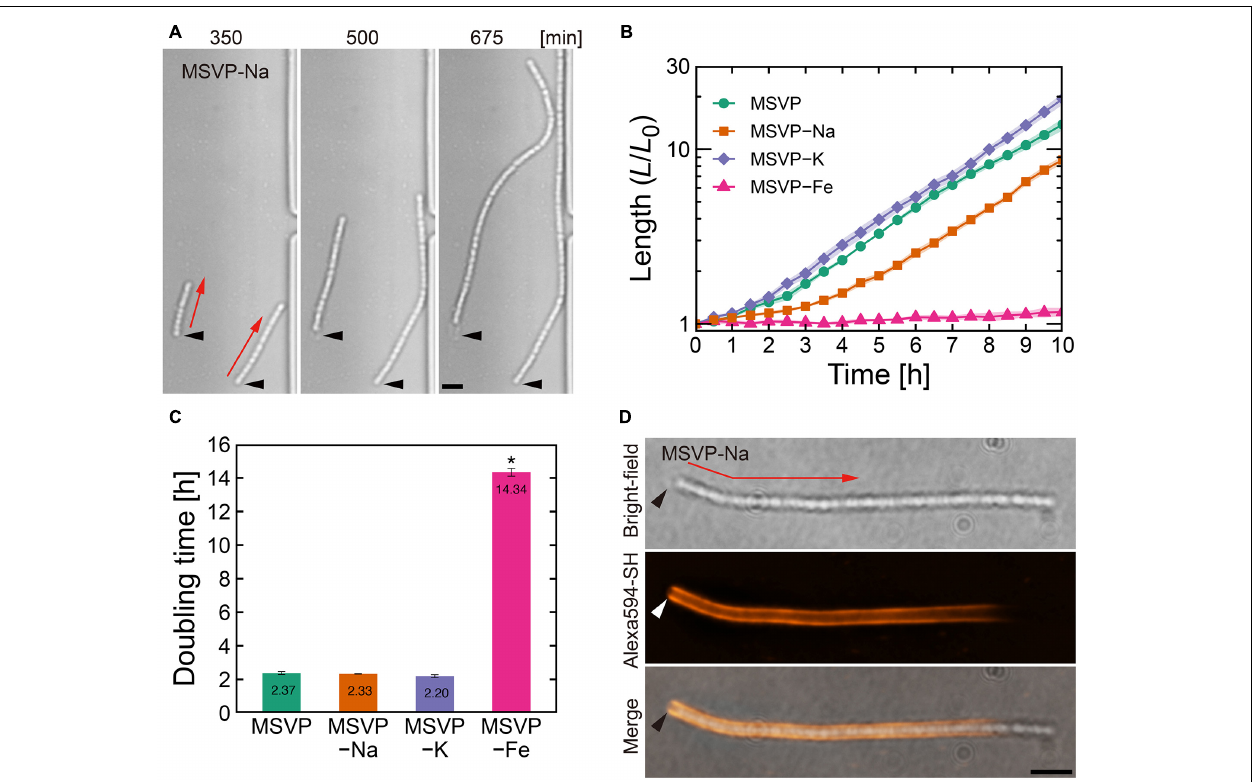
FIGURE 1 | Filament elongation in the normal mode. (A) Time-lapse image sequence showing filamentous growth in MSVP-Na. The start time ( t = 0) is defined as when the first cell makes initial surface attachment. (B) Average length of three independent cell filaments measured as a function of time in MSVP, MSVP-Na, MSVP-K, and MSVP-Fe. The filament length ( L ) is normalized by the initial length ( L 0 ) at t = 0. Filled regions represent the standard deviation (SD) from three experiments. (C) Doubling time of filament length during exponential growth in MSVP, MSVP-Na, MSVP-K, and MSVP-Fe, respectively, measured from three cells. The error bars represent the SD. The significant difference compared to growth in MSVP is calculated using Dunnet’s test ( n = 3, * P < 0.0000001). (D) Fluorescent labeling of the mature sheath surrounding a cell filament grown in MSVP-Na. Black and white arrowheads indicate the same spatial position in each image while red arrows indicate the direction of elongation. Scale bars = 5 µ